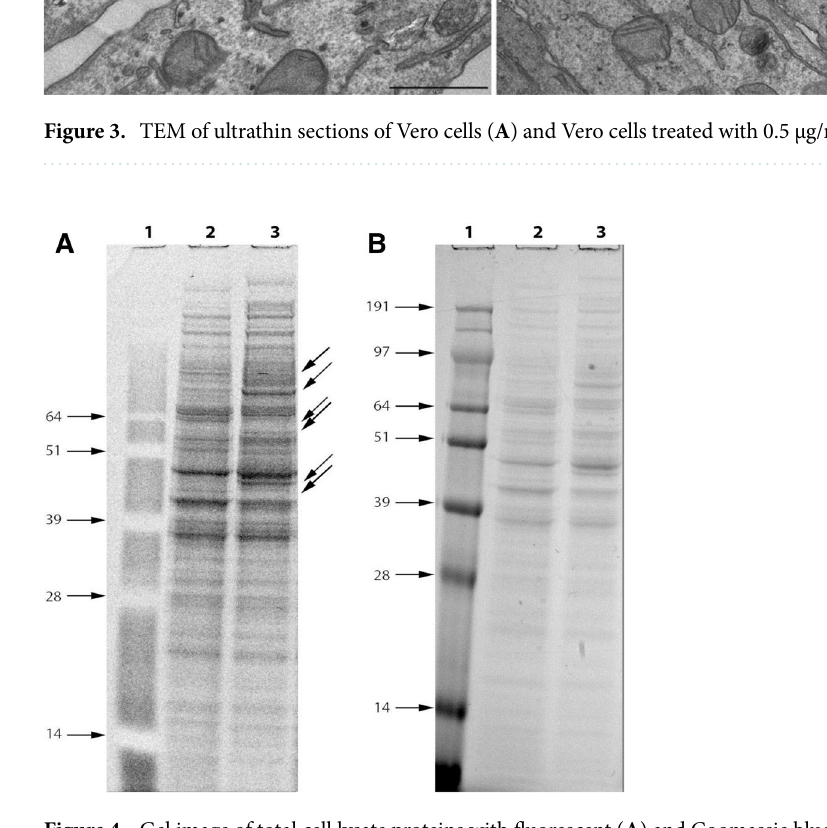
Figure 4. Gel image of total cell lysate proteins with fluorescent ( A ) and Coomassie blue ( B ) staining. A protein molecular weight standard ladder (kDa) is shown in lane 1 while mock- and TIZ-treated Vero cells for 24 h are shown in lane 2 and 3, respectively. Arrows show examples of bands that are differentially visible in the